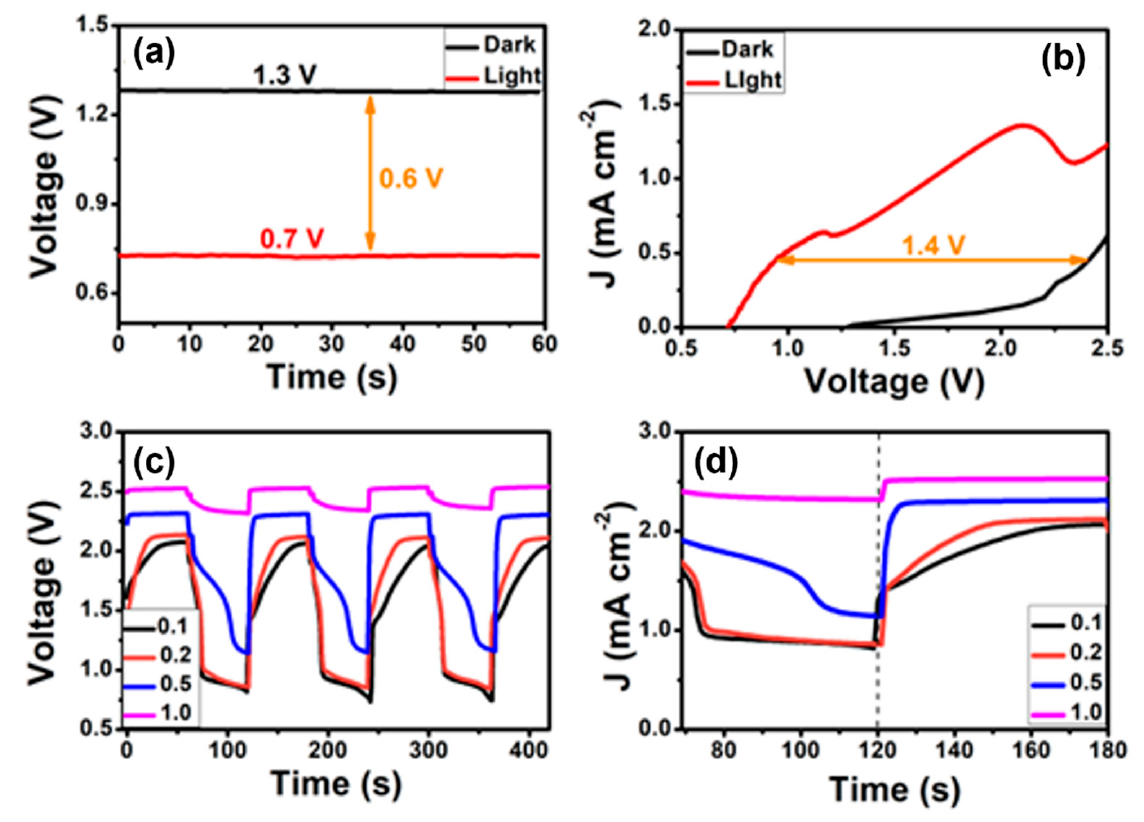
Figure 5. Open-circuit voltage measurements ( a ), current density-voltage curves ( b ), chronopoten- tiometry through chopped illumination ( c ), and zoom of the second cycle ( d ) for a cell comprising a Nb 2 O 5 -CdS photoelectrode and zinc as the counter-electrode in an alkaline electrolyte. The current flowing through the cell can be monitored by varying the external bias.